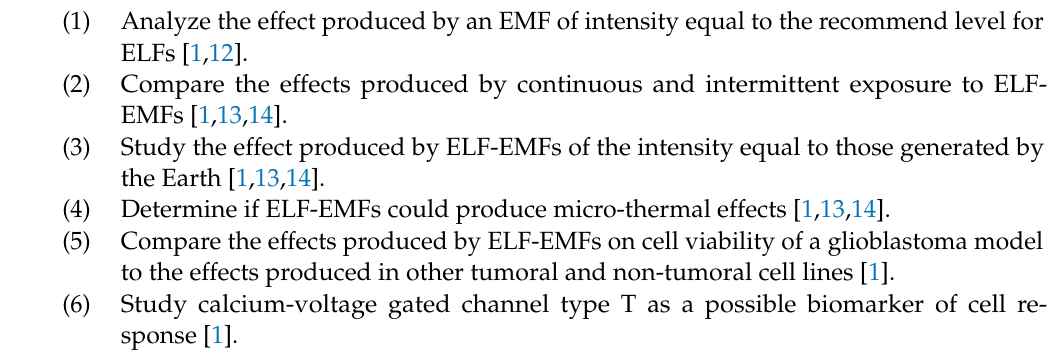
Figure 2. Schematic summary of the experiments designed and performed to archive our goals [1,12–14]. In each experiment, the cell line studied is summarized, and the exposure parameters of the experiment and the parameter (target) is analyzed after the